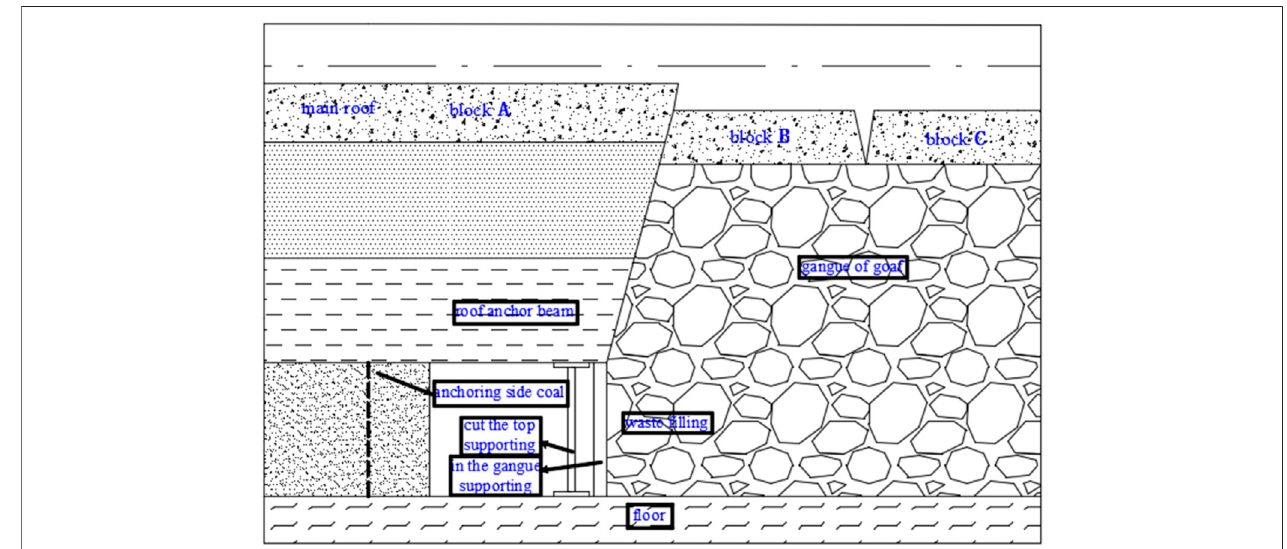
FIGURE 1 | Control diagram of “ anchor - cut - support - block - close ” of un fi lled gob-side entry retaining structure.